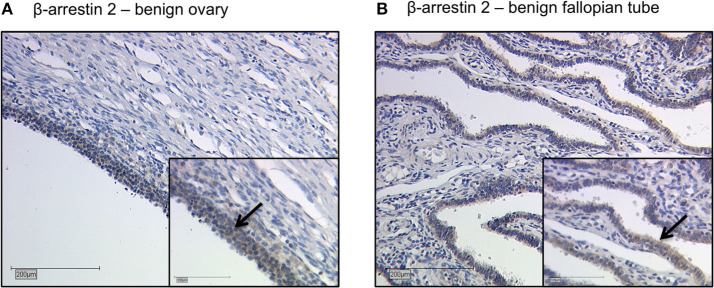
Detection of β-arrestin 2 with immunohistochemistry in benign ovary and fallopian tube. Detection of β-arrestin 2 with immunohistochemistry in benign ovary (A) and fallopian tube (B). Positive β-arrestin 2 staining was observed in epithelial cells, granulosa cells and theca cells. The ovarian and fallopian tube stroma did not show a β-arrestin 2 staining. Arrows demonstrate representatively β-arrestin 2 stained cells. Images representative of three independent experiments.